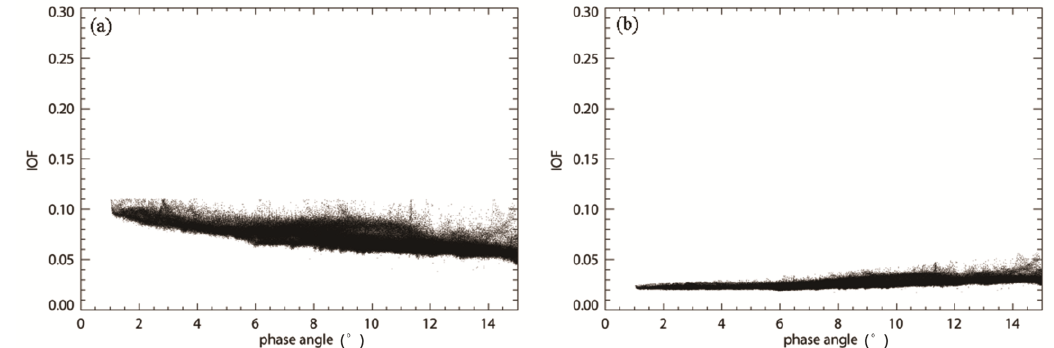
Figure 7. Reflectance data of orbit 2576 with phase range 0~15° before ( a ) and after ( b ) photometric correction by Hapke model.